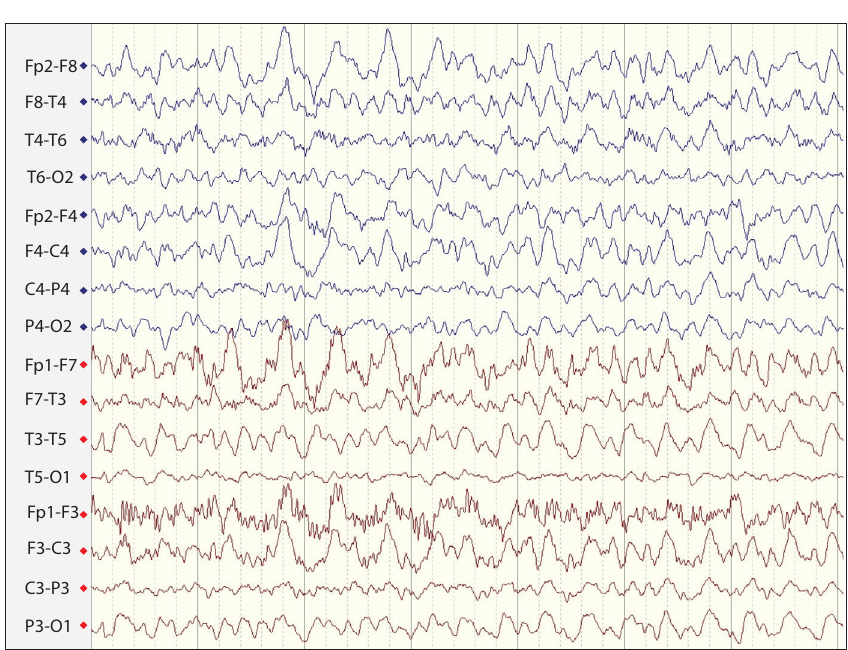
Fig. 1. A diagnosis of complex partial status epilepticus was reported according to the EEG